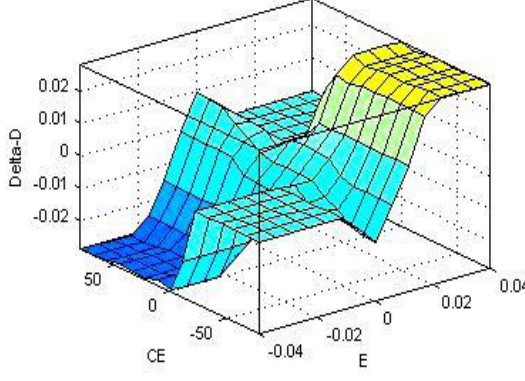
Figure 5. Fuzzy control surface for MPPT.